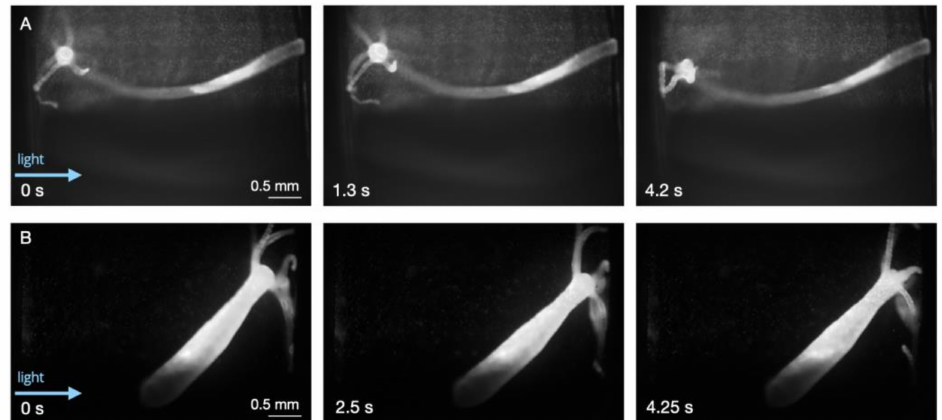
Figure 2. Baseline behavior during static conditions as an indicator of overall health. ( A ) Elongation and tentacle movement. The head (hypostome and tentacle ring) are also visible. ( B ) A different animal in an elongated state inside a chamber. Using SPIM-Flow, GFP-positive neurons could be visualized, depending on the orientation and state of the Hydra (excitation 488 nm and emission 500 nm long pass).